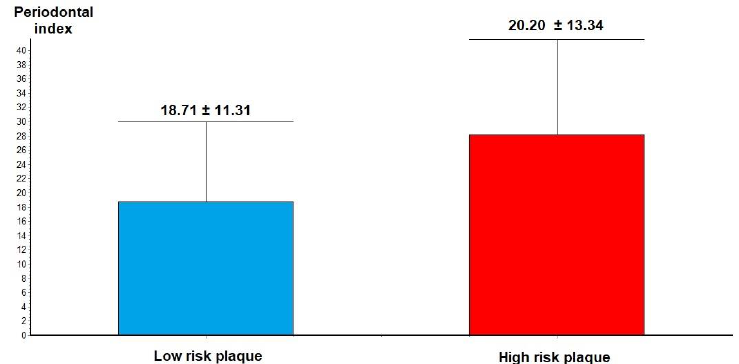
Figure 3. Periodontal index in low-risk plaque vs. high-risk plaque.